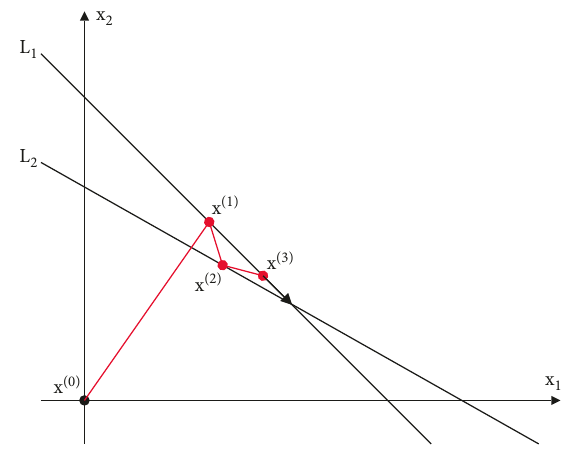
Figure 8: Schematic diagram of the solution process of the Kaczmarz method.